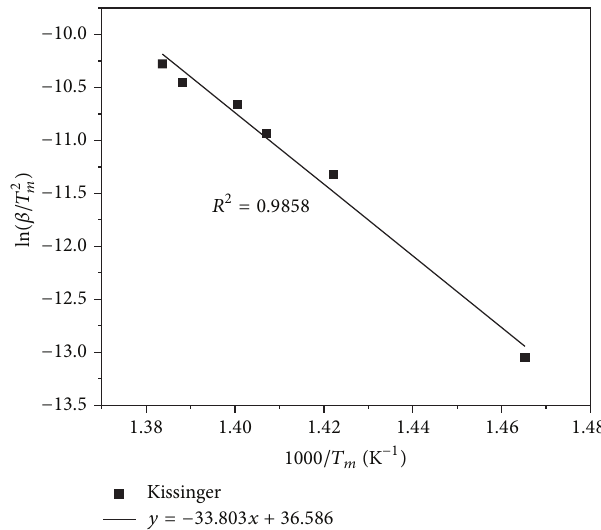
Figure 4: Kissinger plot of lignite coal pyrolysis at different heating rates.